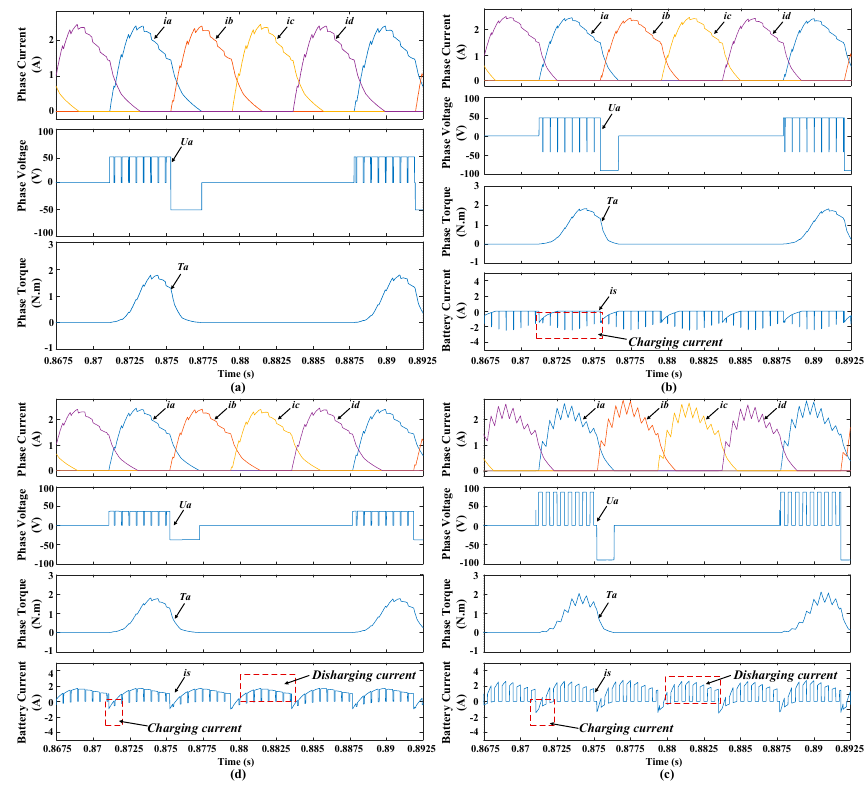
Figure 14. Simulation waveforms of 600rpm performance with SRM driven by ( a ) the conventional converter, ( b ) the PV panel, ( c ) the battery bank, and ( d ) the dual-source.